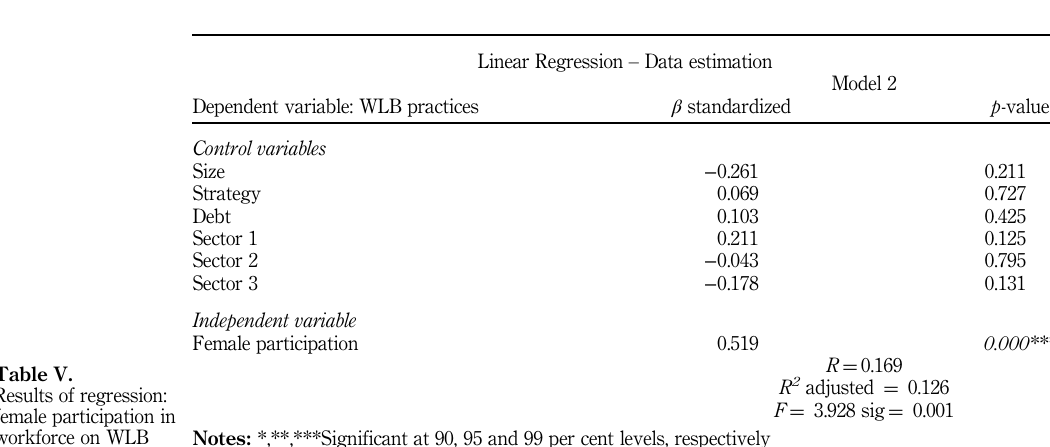
Table IV. Results of regression: female participation in workforce on financial performance